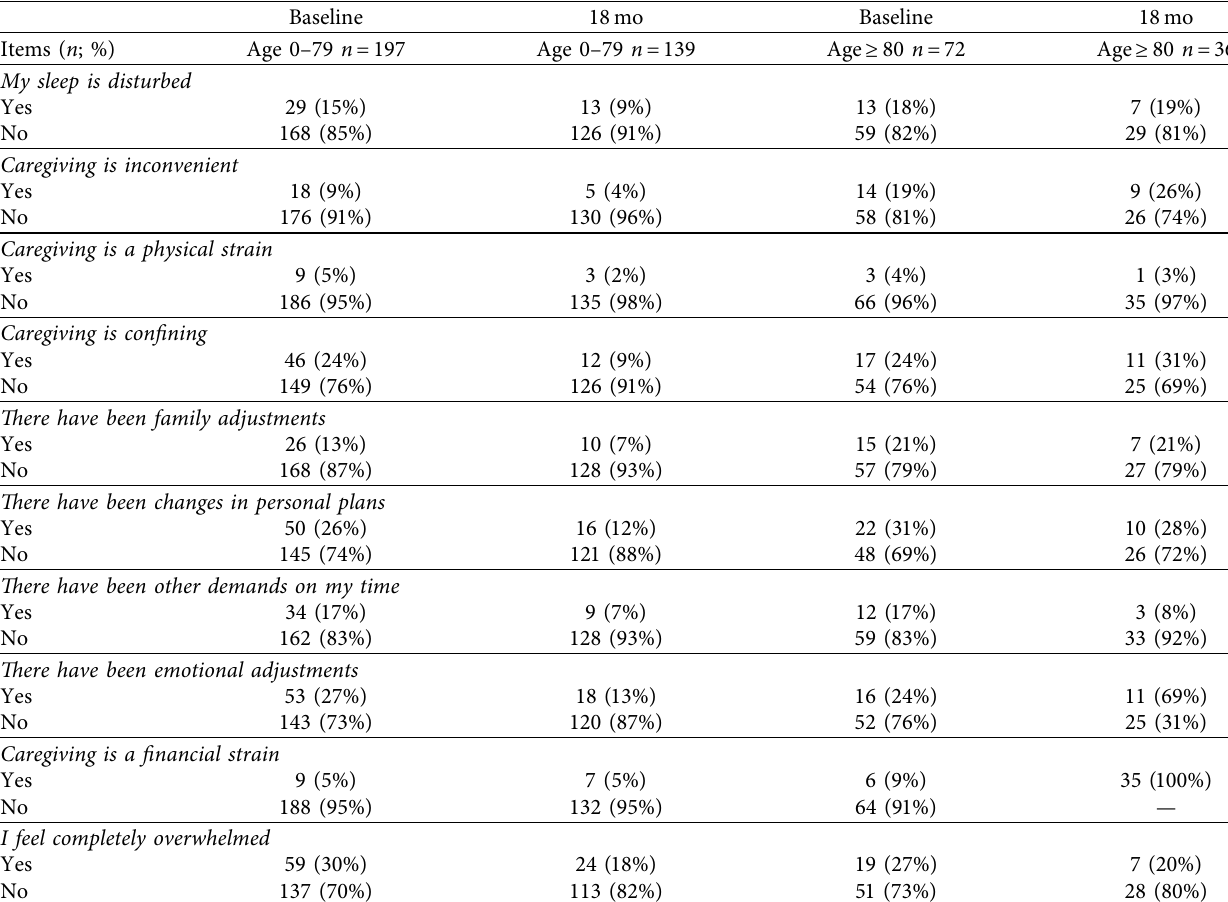
Table 4: All answers of the Caregiver strain index (CSI) at baseline and 18-month (mo) follow-up in groups divided in age groups 0–79 years and > 80 years, with yes/no answers in answer frequencies ( n ) and percentages